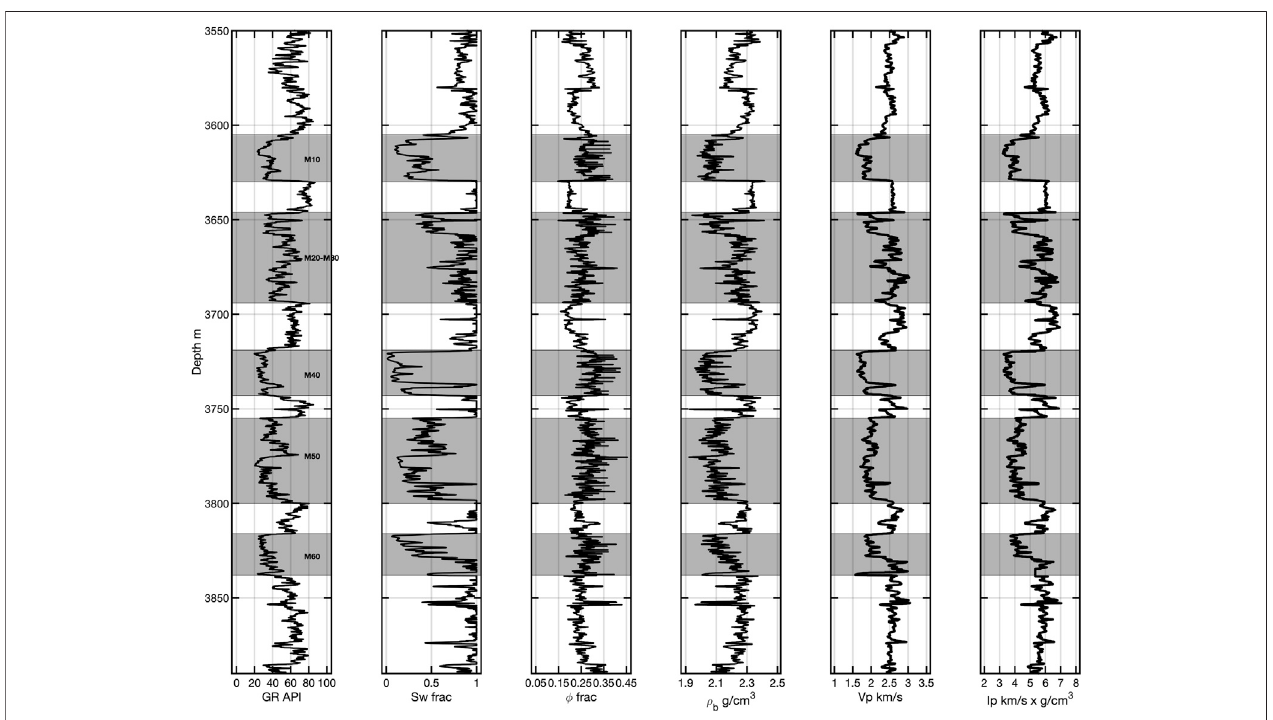
FIGURE 1 | Log data from the Gulf of Mexico data set. Included are (A) gamma ray, (B) water saturation, (C) porosity, (D) density, (E) P-wave velocity, and (F) P-impedance. In gray are the M10-M60 sands, also labeled in (A) . The sands have lower impedances than the shales and tend to separate cleanly in that domain.